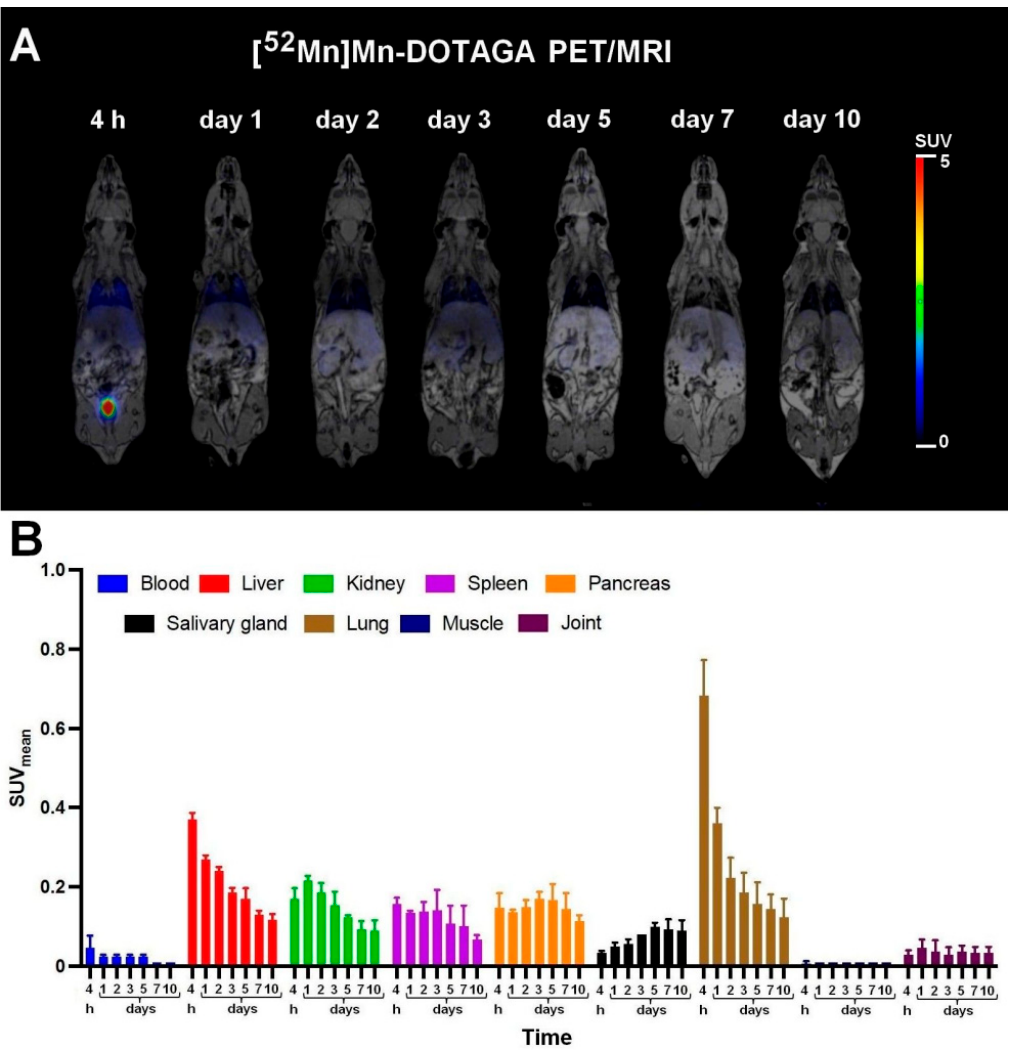
Figure 4. In vivo PET/MRI imaging of [ 52 Mn]Mn-DOTAGA biodistribution ( A ) and average time- activity changes ( B ) of the selected organs 4 h, 1, 2, 3, 5, 7, and 10 days after the intravenous injection of approximately 10 MBq of [ 52 Mn]Mn-DOTAGA. SUV: standardized uptake value. Data are shown as mean ± SD and obtained from n = 5 animals.